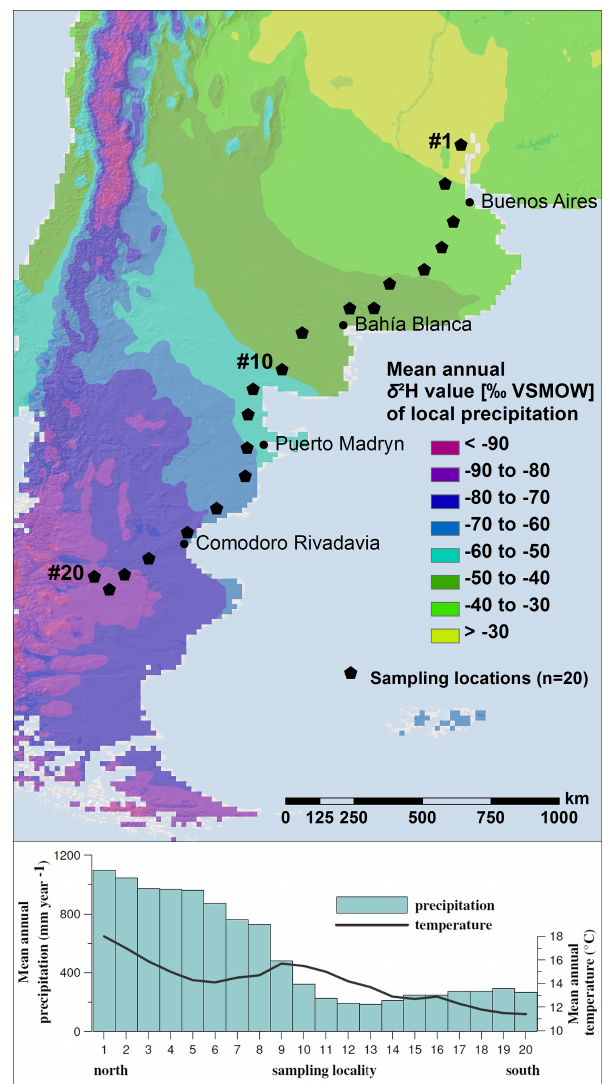
Figure 1. Sampling locations along the investigated transect in Ar- gentina. The colors illustrate the gradient in δ 2 H prec , and mean an- nual temperature and precipitation are shown